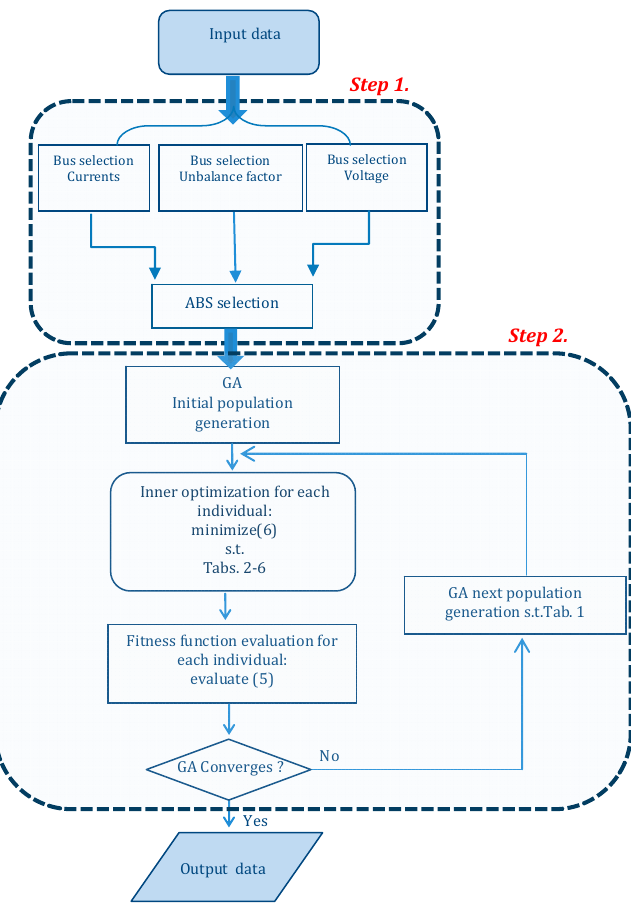
Figure 1. Flow chart of the proposed procedure. GA: genetic algorithm. ABS: allocation bus set.